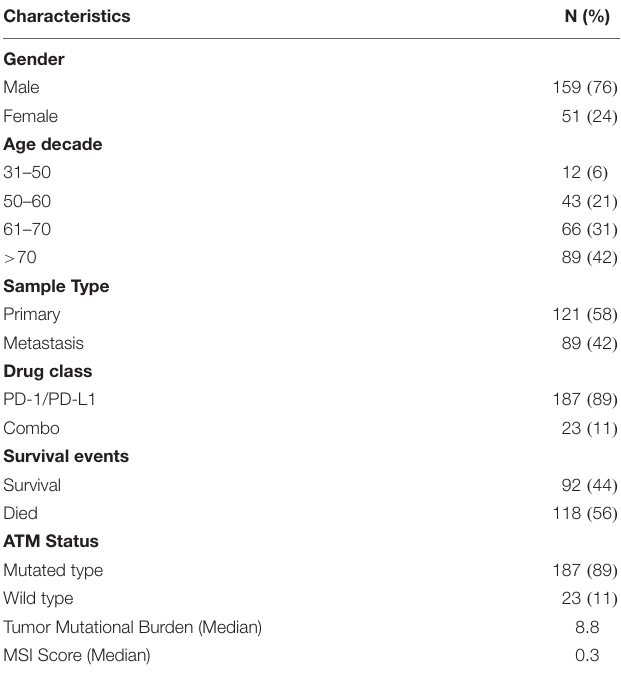
TABLE 1 | The baseline characteristics of the immunotherapy cohort.